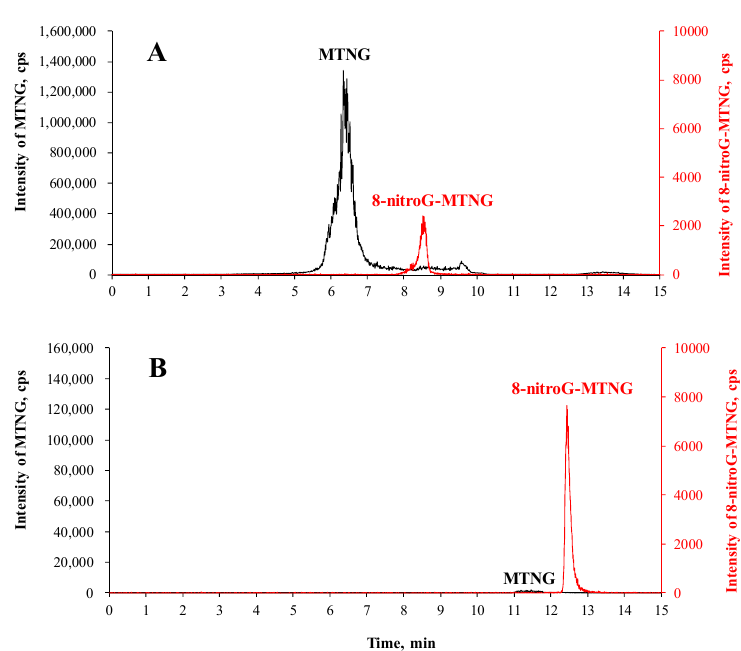
Figure 4. Total ion chromatogram of a derivatized DNA sample during trap column separation ( A ) and analytical column separation after column switching ( B ). MTNG was monitored at m / z 215 → 144 in positive ionization mode with a retention time at 6.3 min and 8-nitroG-MTNG were clearly well separated on the SPE column ( A ), and only the fraction containing 8-nitroG-MTNG at the retention time from 7.5 to 9.5 min was eluted into the analytical column ( B ).